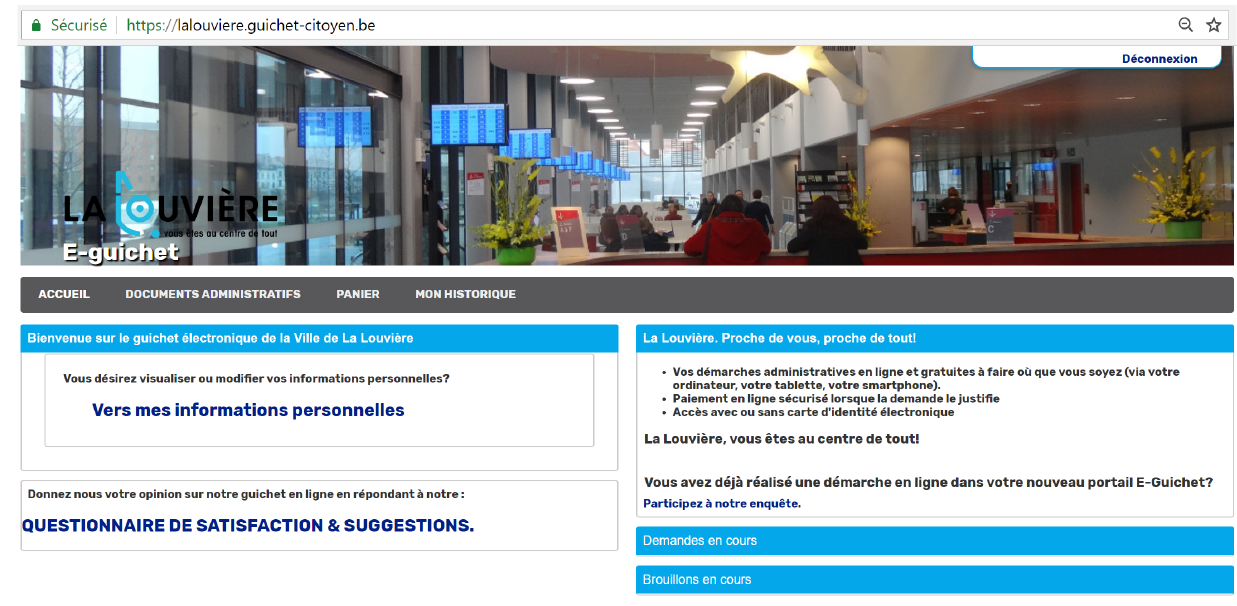
Figure 2. Portal